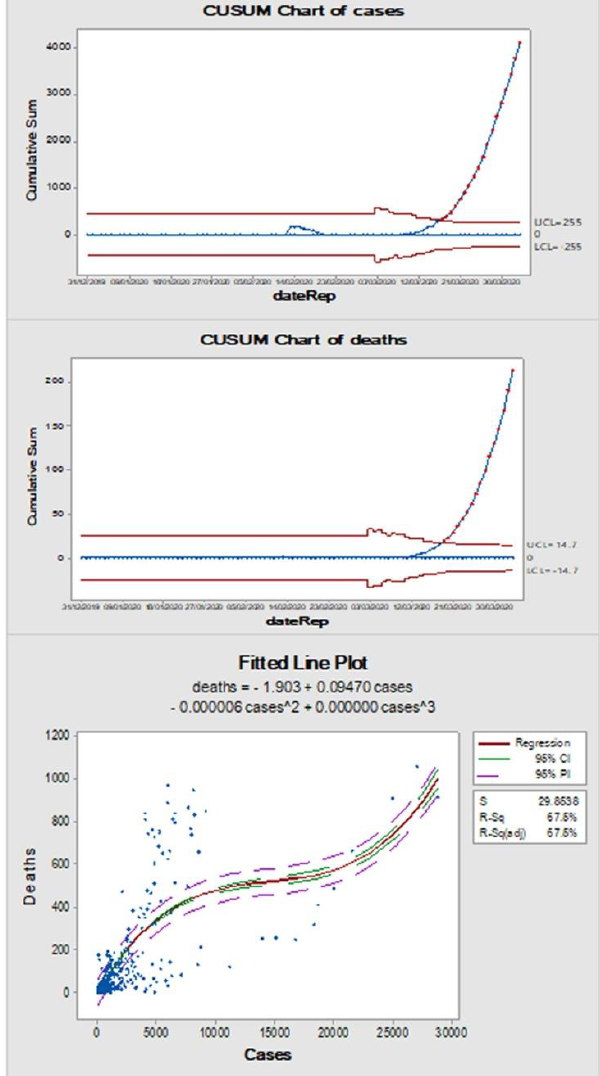
Figure 3: Time-weighted control charts of cumulative sum type for global morbidities and mortalities from Wuhan pneumonia disease and correlation fitting diagram between the outbreak cases and